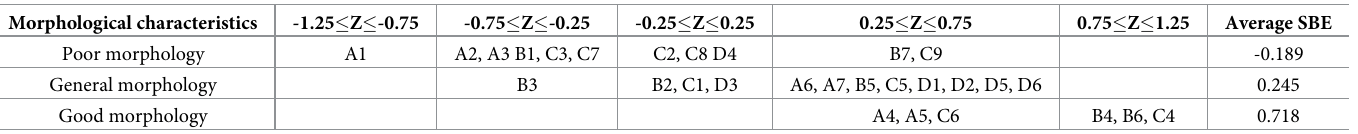
Table 7. SBE scores of samples based on morphological